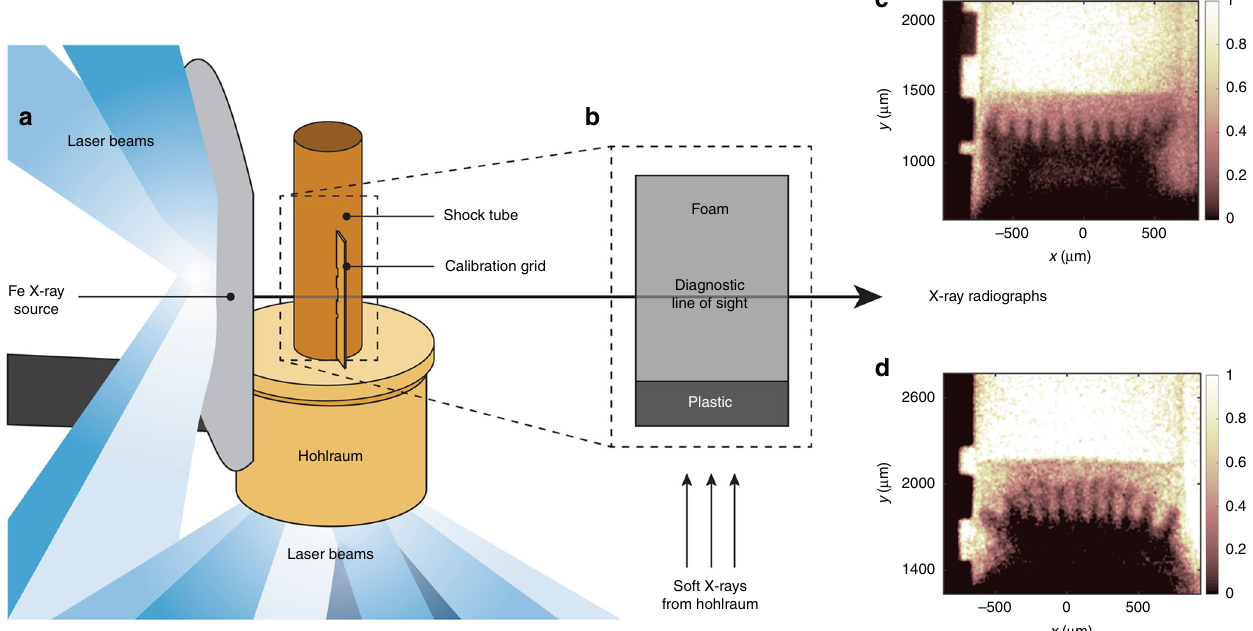
Fig. 1 Experimental target and radiographs. a NIF target schematic with laser beams incident on the gold hohlraum to create the X-ray drive and on the large-area backlighter to create the diagnostic X-ray source. Attached to the hohlraum is a plastic shock tube. The soft X-rays from the hohlraum create a shock wave in the plastic layer inside the shock tube b , which decays into a blast wave before crossing the unstable interface and entering the foam. The diagnostic X-ray source creates radiographs by being preferentially absorbed by a tracer layer in center of the plastic. c , d X-ray radiographs of the experiment. Here, the plasma fl ows upward and the dark fi ngers are due to RT instability growth. The color bar indicates the relative transmission for c the high- fl ux case at t = 13 ns and d the low- fl ux case taken at t = 34 ns. The two experiments have similar RT growth factors, as described in the